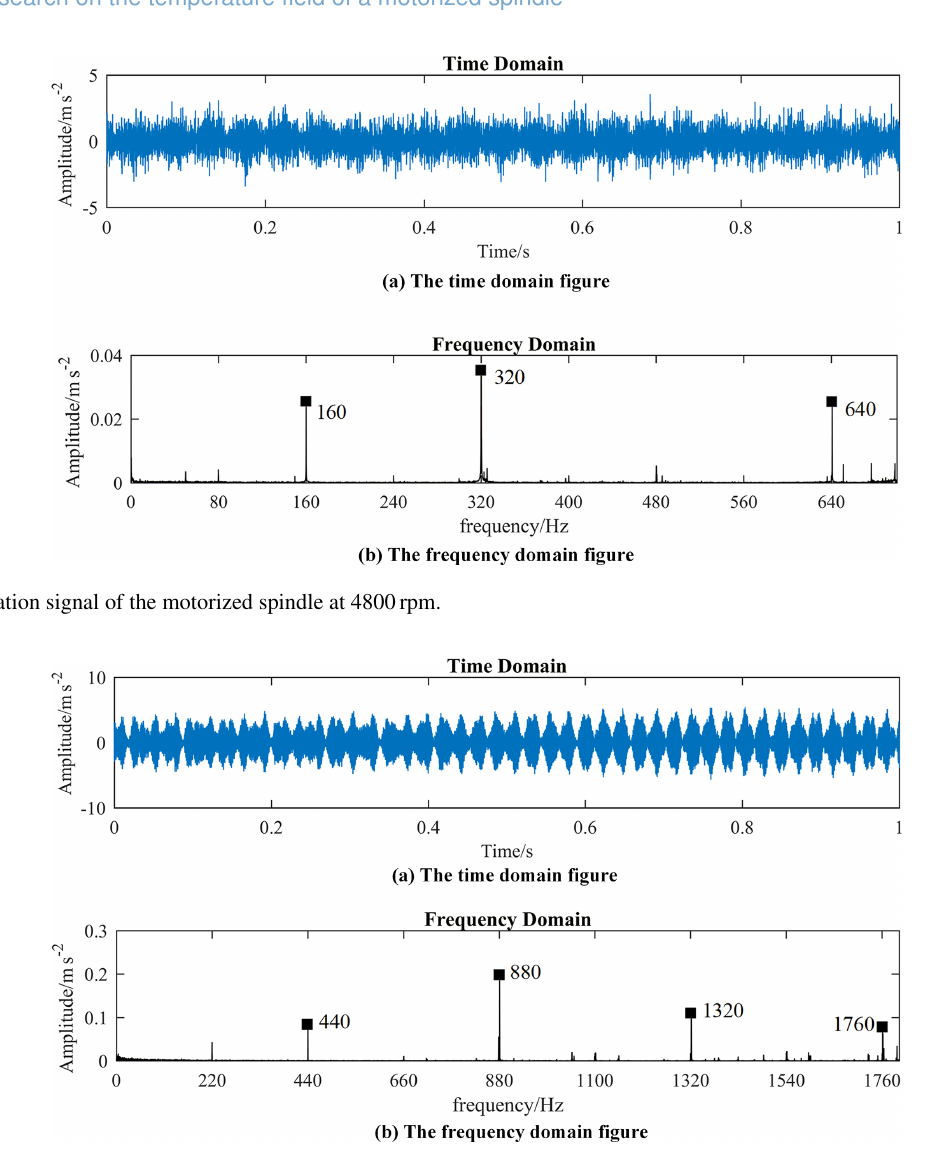
T min . Then the circumferential maximum temperature differ- ence is calculated by (cid:49)T = T max − T min